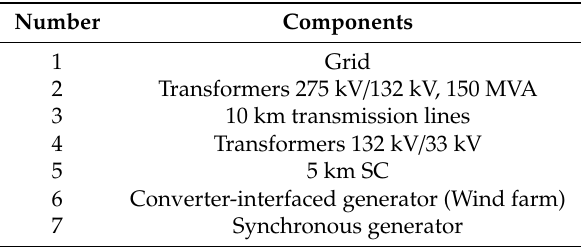
Figure 6. Case study test network. Table 2. Components of the tested system.